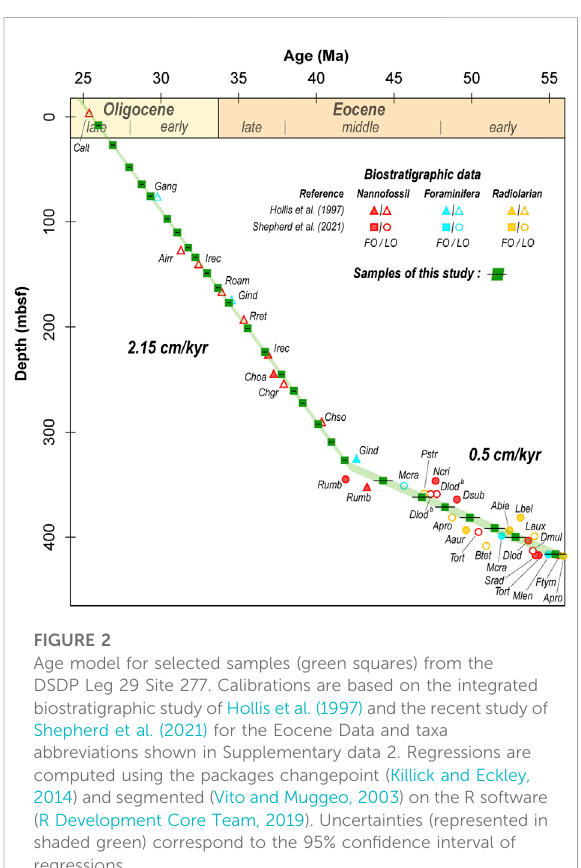
FIGURE 2 Age model for selected samples (green squares) from the DSDP Leg 29 Site 277. Calibrations are based on the integrated biostratigraphic study of Hollis et al. (1997) and the recent study of Shepherd et al. (2021) for the Eocene Data and taxa abbreviations shown in Supplementary data 2. Regressions are computed using the packages changepoint (Killick and Eckley, 2014) and segmented (Vito and Muggeo, 2003) on the R software (R Development Core Team, 2019). Uncertainties (represented in shaded green) correspond to the 95% con fi dence interval of